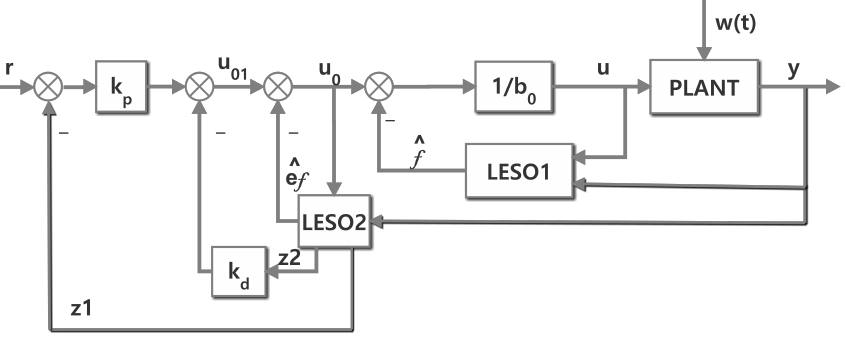
Figure 2. Structural diagram of the improved linear active disturbance rejection controller